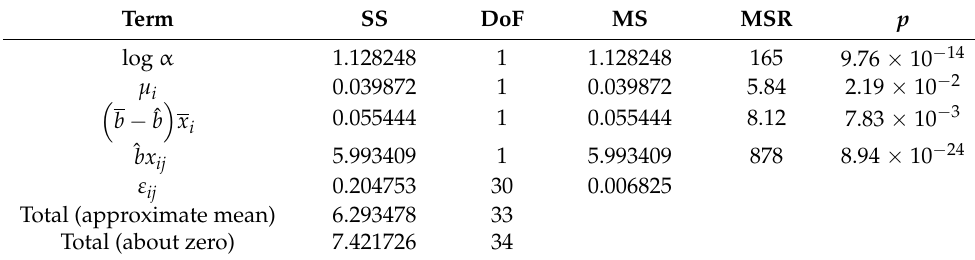
Table 2. Summary of the one-way ANCOVA results for respirometric tests in F 2 bester using Equation (5). SS, sum of squares; DoF, degrees of freedom; MS, mean of squares; MSR, mean square